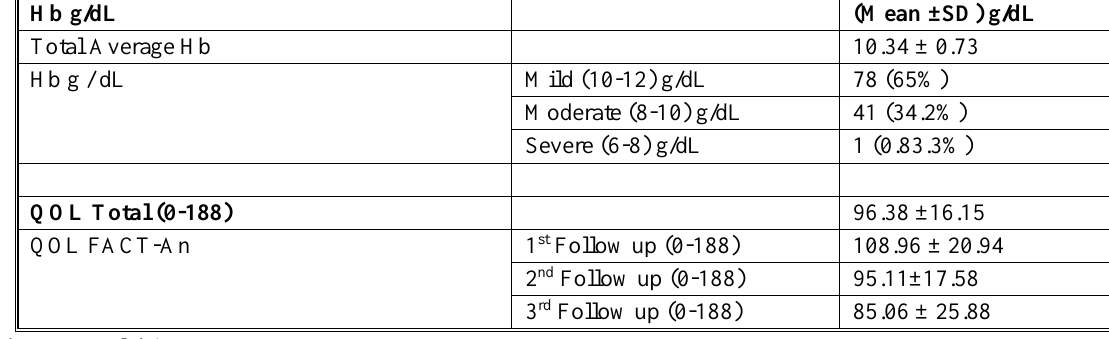
Table 2.Mean of Hb level (severity of anaemia) and QOL in breast cancer patients (N= 120) Hb g/dL